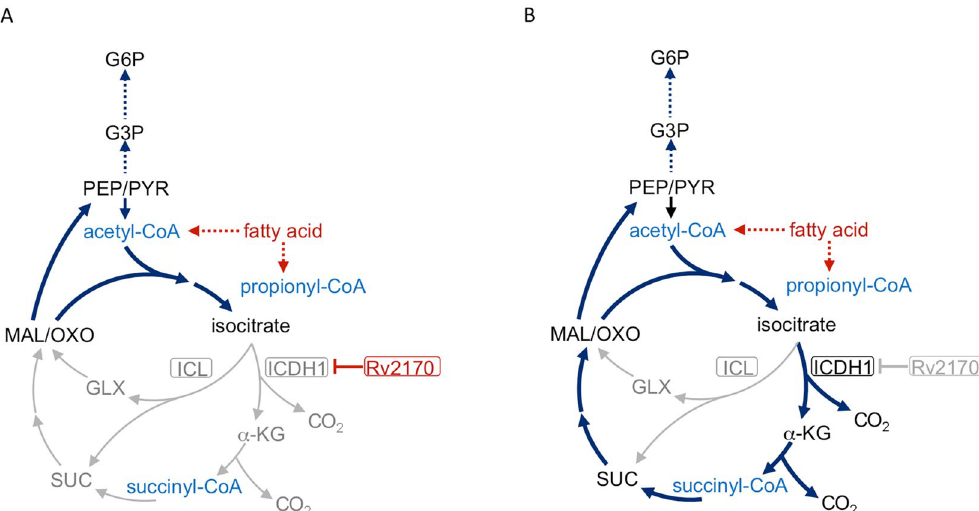
Figure 7. Carbon metabolism modulation by Rv2170. A diagram modeling the “preferred” metabolic fate of carbon at the metabolic node isocitrate. Rv2170, an ICDH1 acetyltransferase modulates carbon flow to either closing ( A ) or opening ( B ) toward TCA cycle during growth on stearic acid as sole carbon substrate. The direction of the dominant carbon flow is indicated by black instead of grey arrows. The CoA substrates utilized by Rv2170 are shown in blue. Symbols are as in Fig.